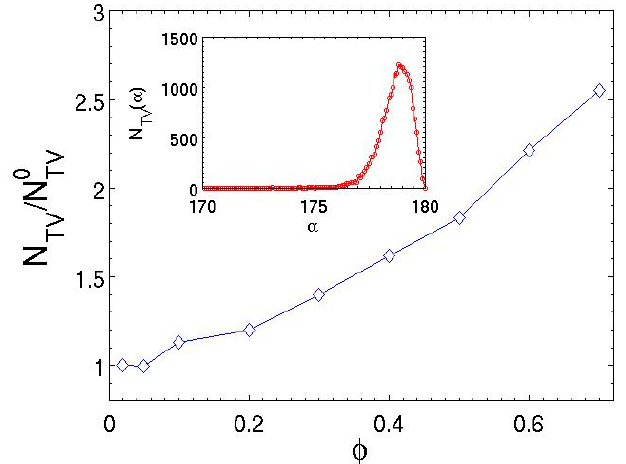
Table 2. Average number of topology violations per 100 τ for in semidilute solutions with different polymer volume fractions. The results are obtained in simulations having a total time of 5000 τ